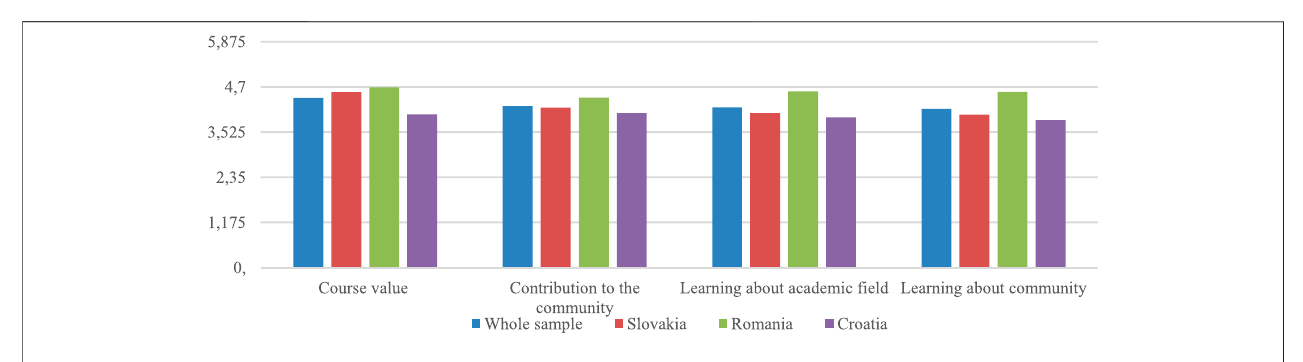
FIGURE 1 | Average on the four subscales of the SL-based course satisfaction measures.